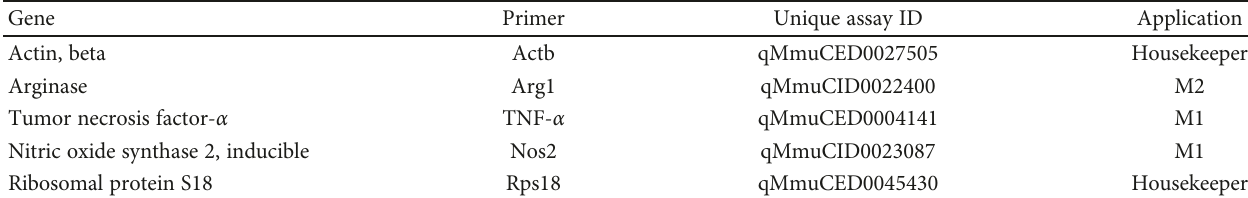
Table 2: PCR primers used for characterization of macrophage